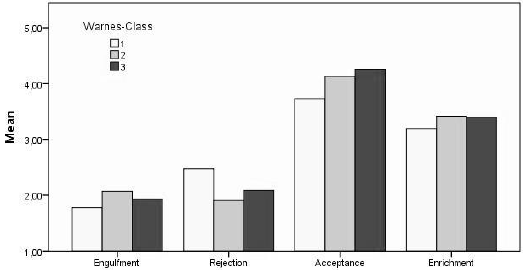
Figure 2. Mean Differences in Illness Identity by Warnes Classification [19]. Figure 2. Mean Di ff erences in Illness Identity by Warnes Classification [19].